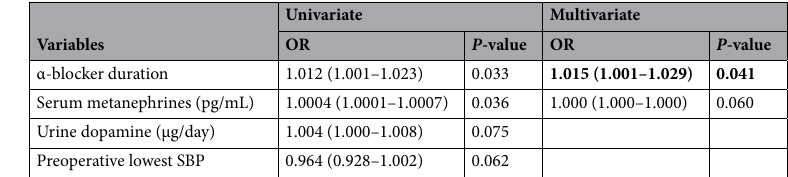
Table 3. Logistic regression analysis for predicting intraoperative hemodynamic instability in PPGL patients. Variables with a P -value < 0.1 in univariate analysis were included in the multivariate logistic regression models. Data are shown as odds ratios (ORs) (95% confidence intervals). PPGL, pheochromocytoma and sympathetic